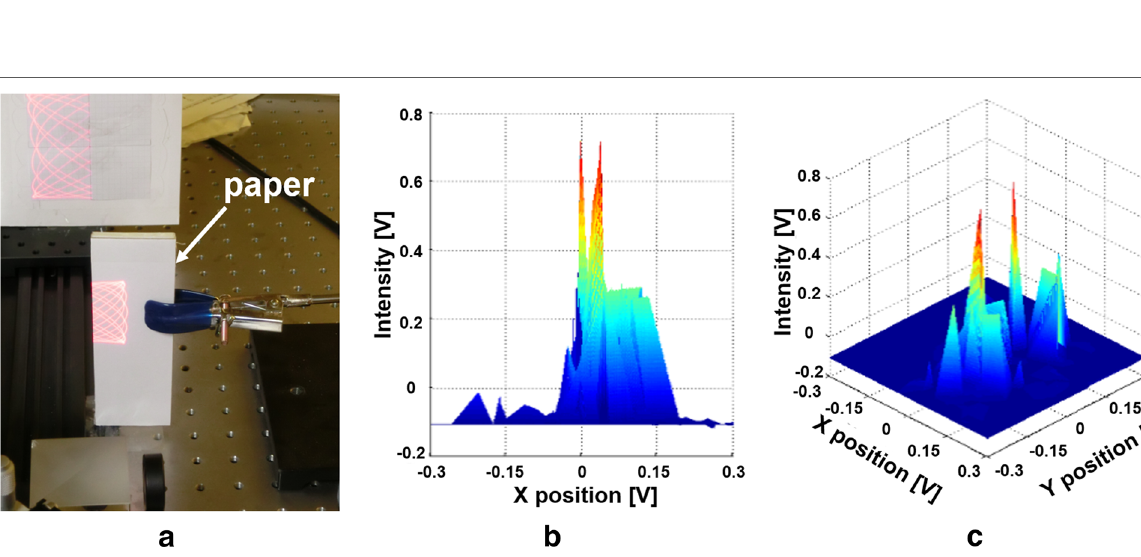
Fig. 7 Position and intensity measurement result of a paper located on the right side: a position of the paper, b intensity of the reflected beam vs. x position, c intensity of the reflected beam vs. xy